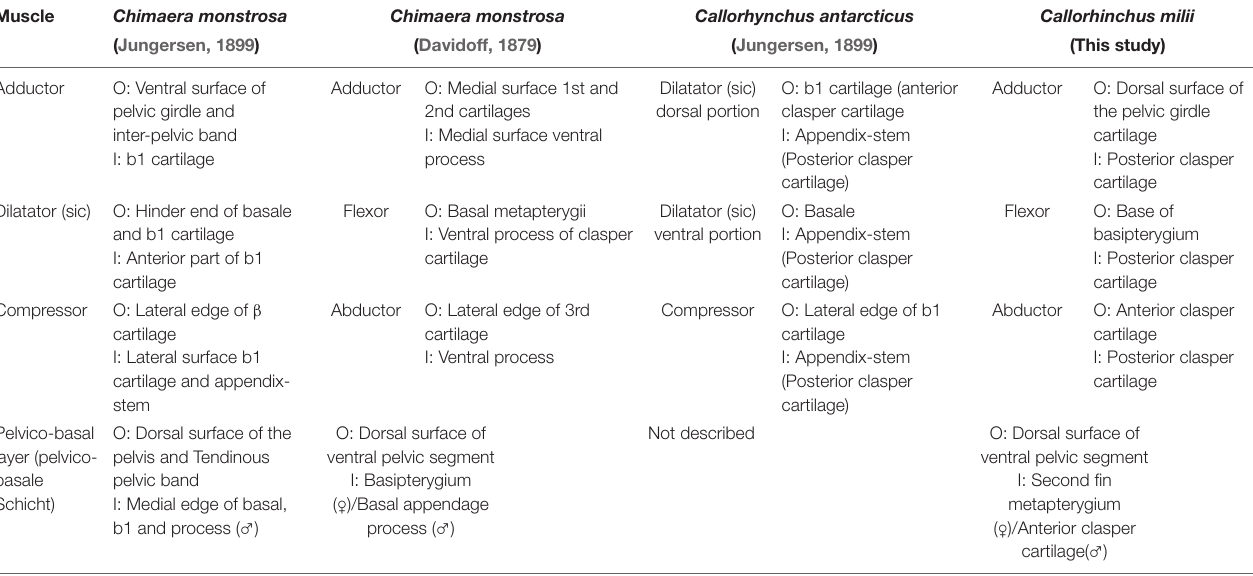
TABLE 5 | Chimaeroid clasper musculature and their points of origin (O) and insertion (I). Muscle